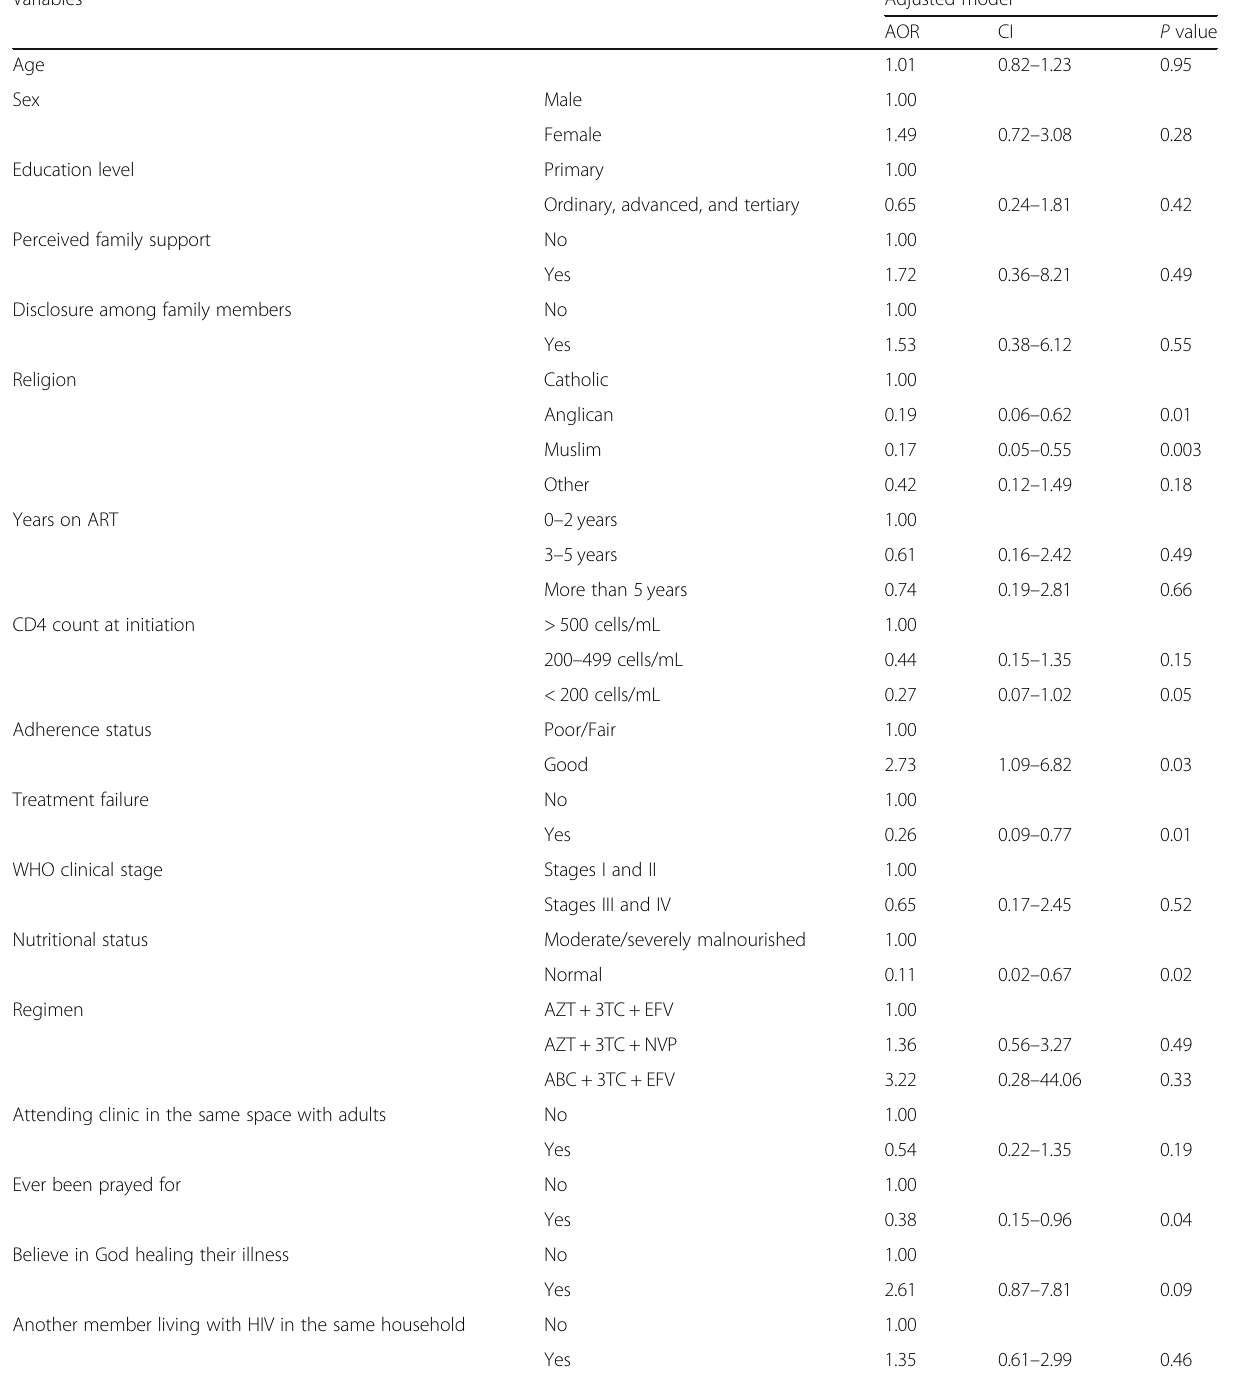
Table 4 Factors associated with viral suppression among adolescents on ART